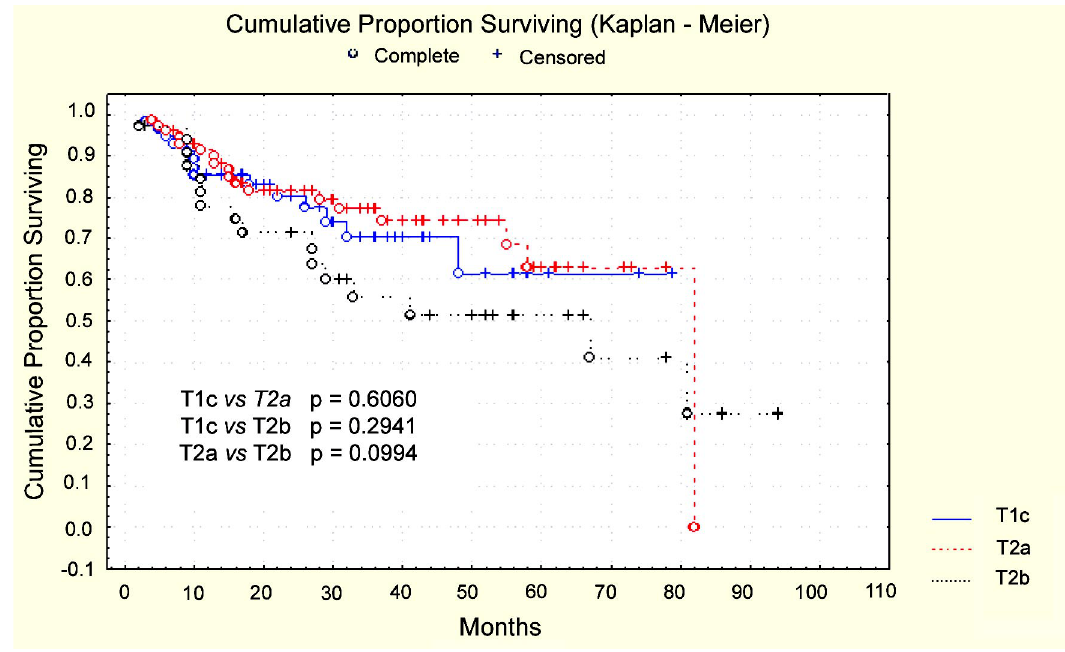
Figure 2 – Time to PSA progression according to clinical stages T1c, T2a and T2b. Kaplan-Meier product-limit